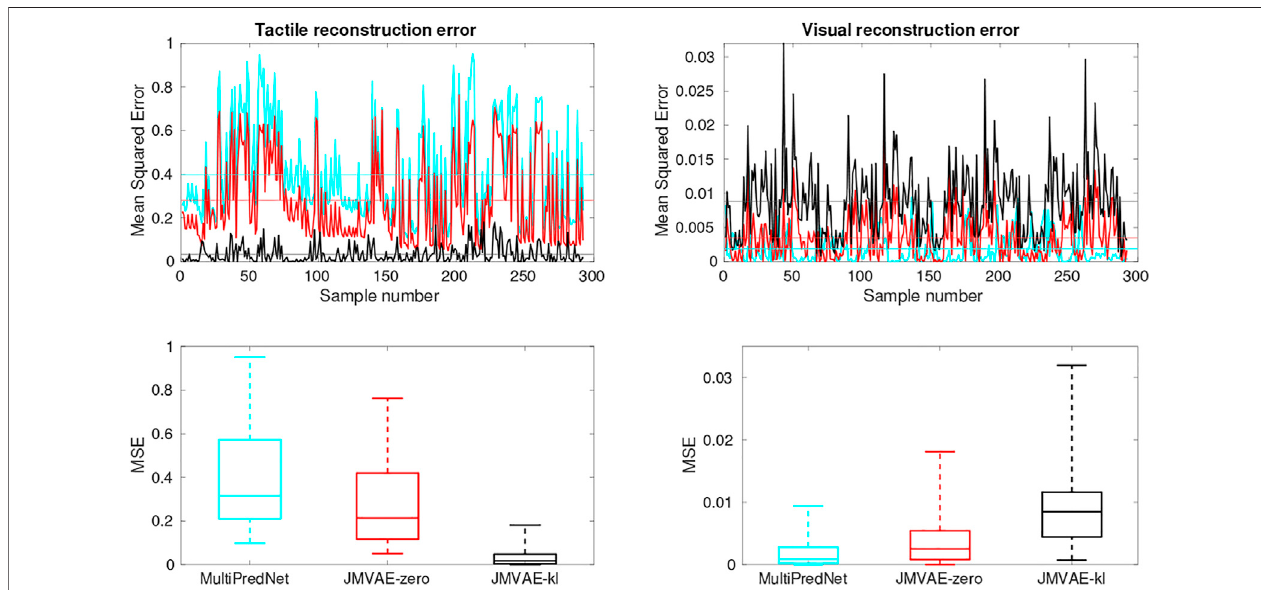
FIGURE 9 | Tactile and Visual reconstruction errors from each sample in all test sets inferred by the MultiPredNet, JMVAE-zero and JMVAE-kl models with the tactile (and visual respectively) sensory input obscured. Note the systematic offset in tactile reconstruction error from the MultiPredNet and JMVAE-zero model as indicated by the mean of the Mean Squared Error (MSE) across all samples (horizontal coloured